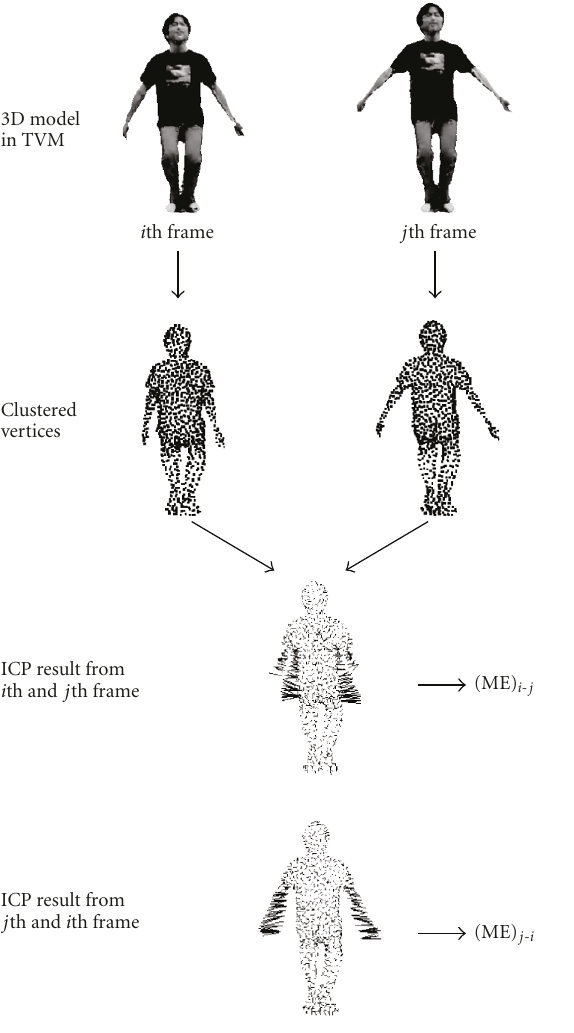
Figure 3: Flowchart to calculate dissimilarity between frames based on ICP algorithm.